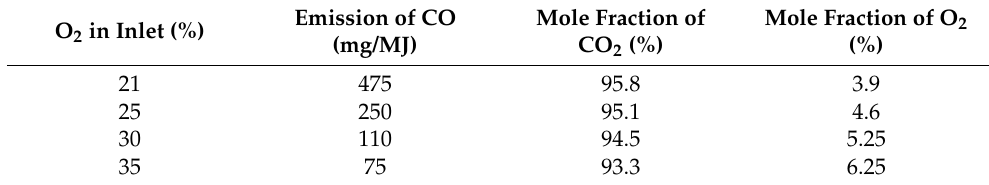
Table 4. Emissions of CO and mole fraction of CO 2 and O 2 for different inlet O 2 concentrations. Emission of O 2 in Inlet (%)